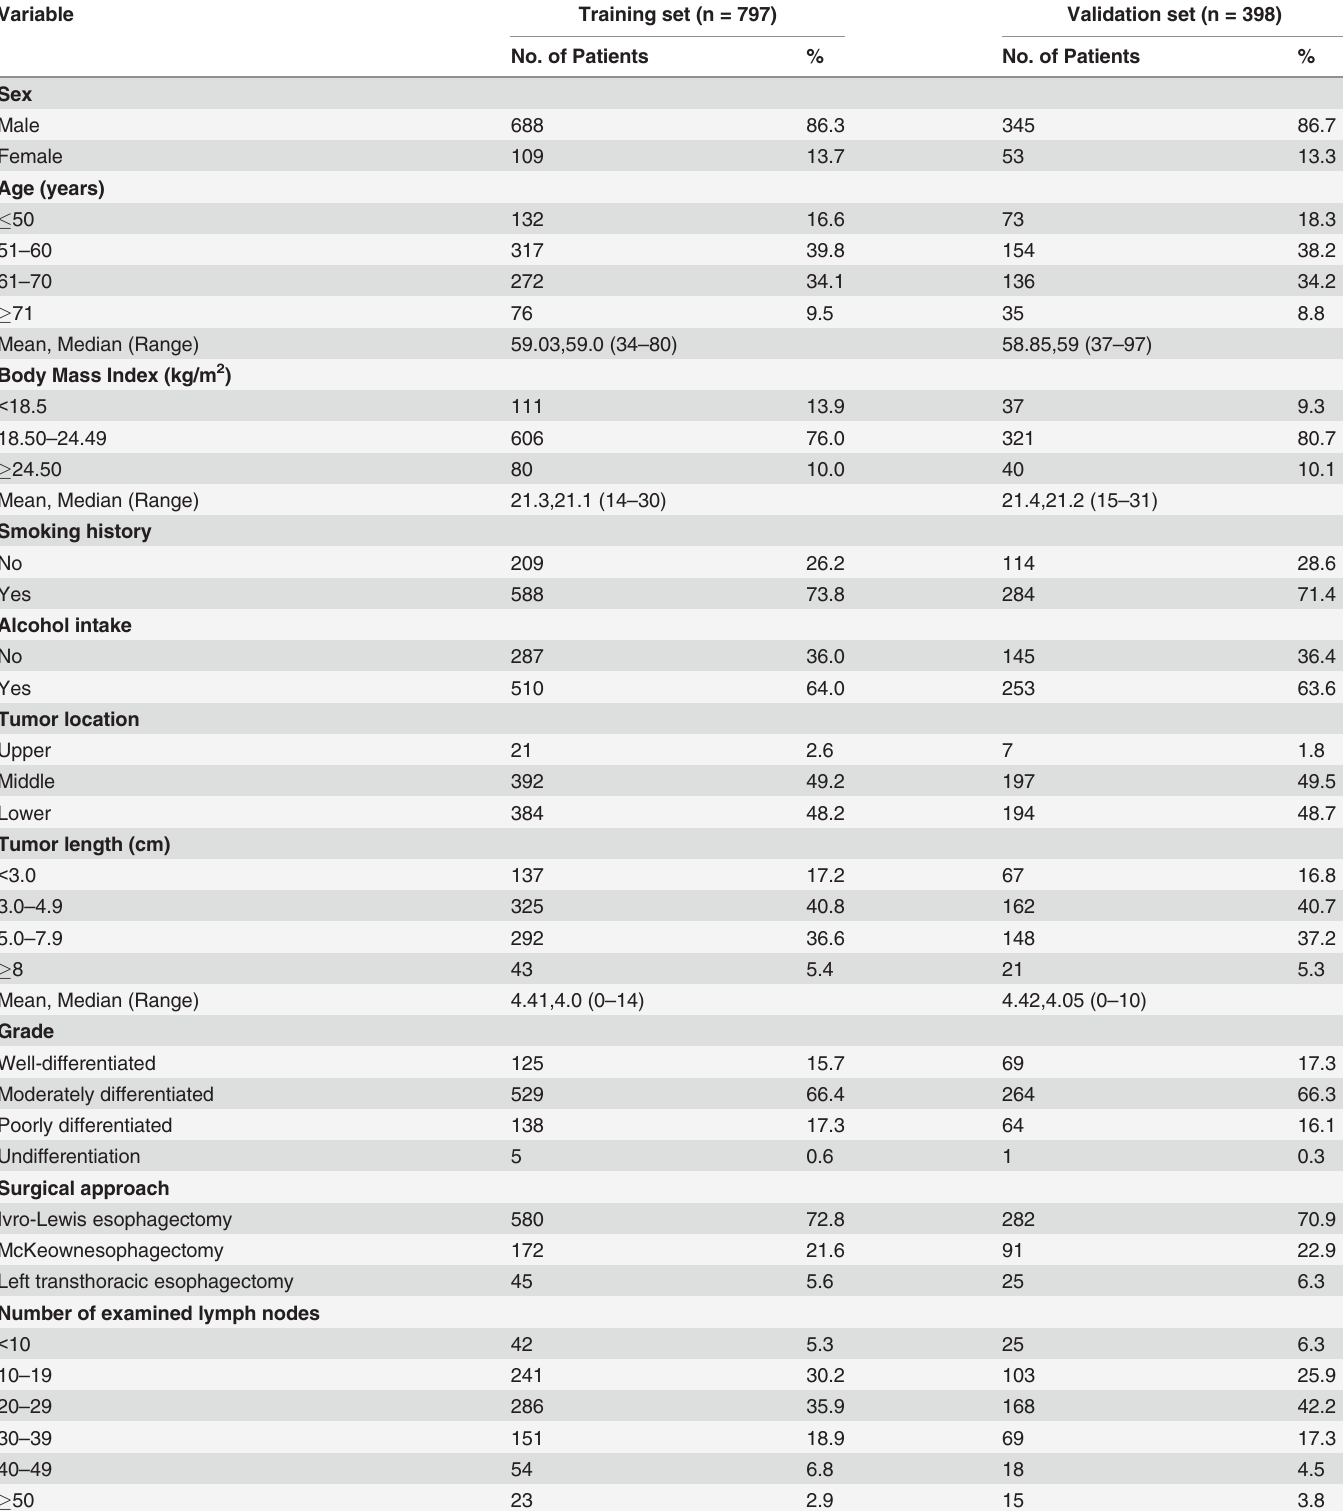
Table 1. Patient clinicopathologic characteristics of the training and validation